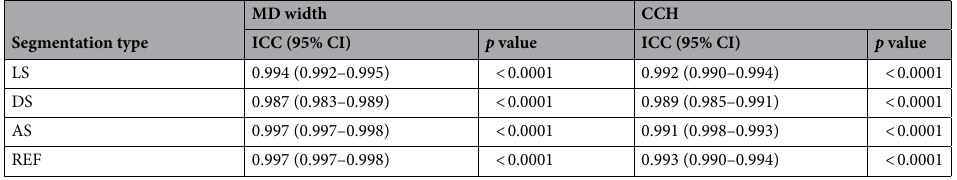
Table 1. Reliability analysis of tooth measurement. MD width and CCH, presented as continuous variables, were verified for intra-rater reliability using ICC. The ICC of MD width and CCH were 0.994–0.997